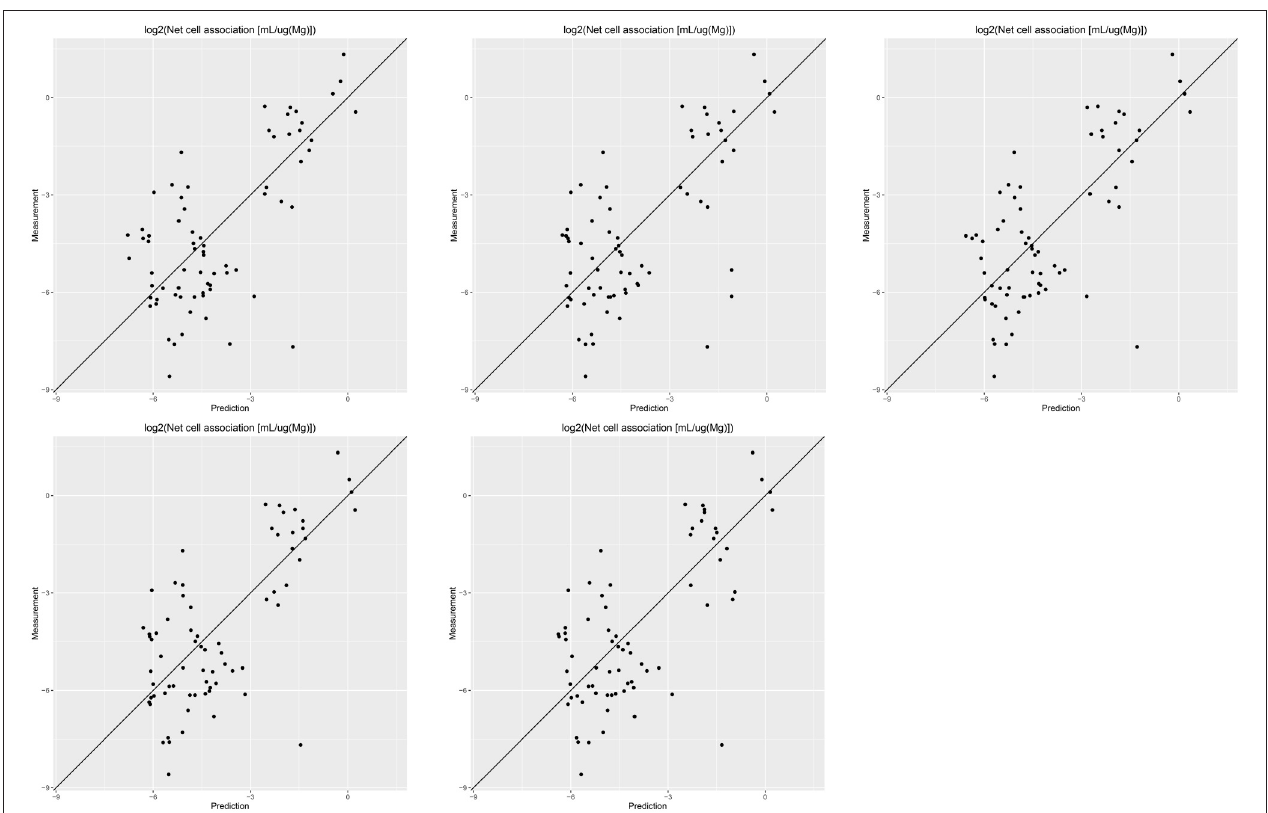
FIGURE 1 | Correlation of predicted vs. measured values for five independent crossvalidations with MP2D fingerprint descriptors and local random forest models.